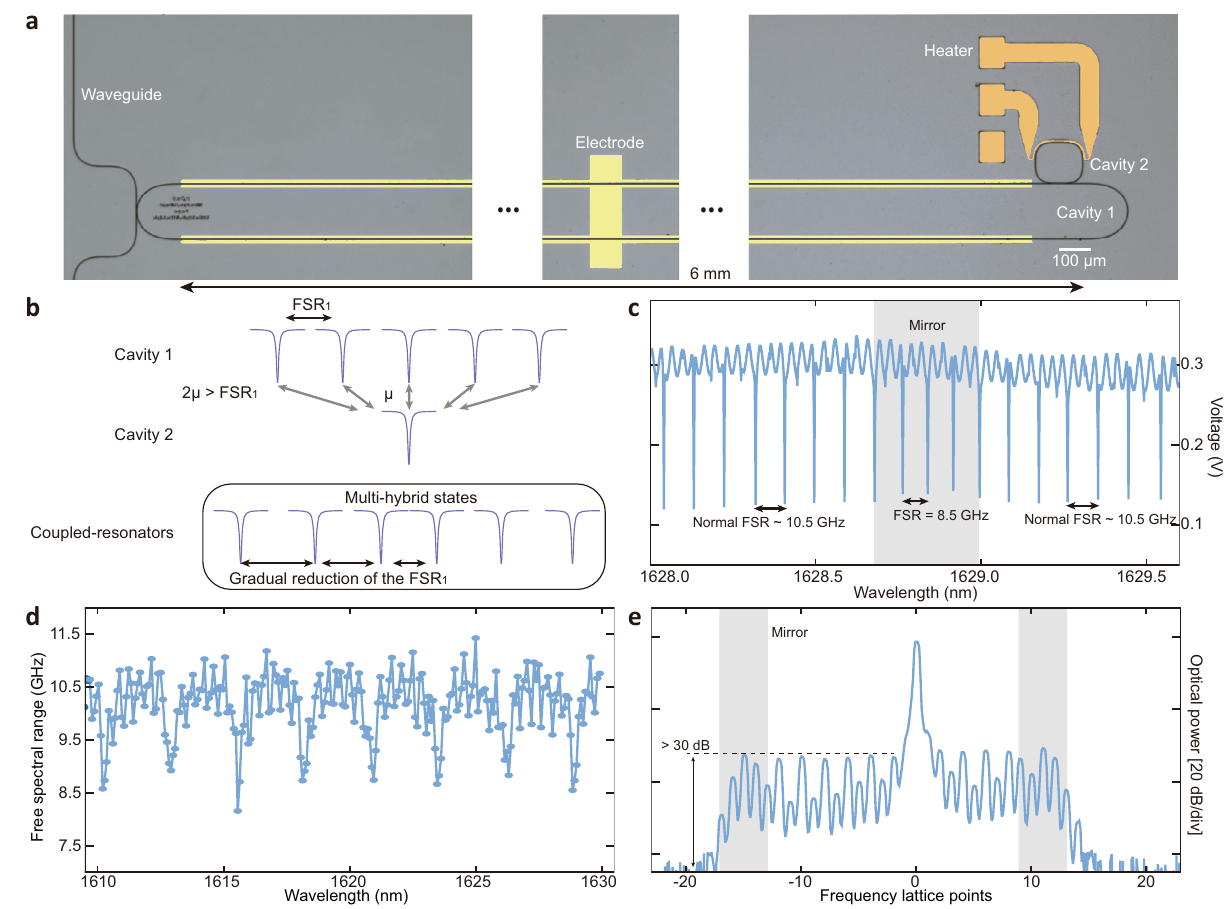
Fig. 4 | Forming trapped states using frequency mirror implemented by coupled-resonators. a Optical image (false-color) of the device. A long racetrack shape cavity (cavity 1) with FSR 1 of 10.46GHz is used to generate the frequency crystal. A rectangular shape (cavity 2) with FSR 2 of 302.9GHz is coupled to the cavity 1 to provide the frequency mirrors. Metal electrodes (light yellow) provides theef fi cientmicrowavemodulation.Thermalheater(orange)cantunetheposition of the mirrors by varying the resonances of cavity 2. b Illustration of the coupling between two resonators when the coupling strength satis fi es 2 μ >FSR 1 or μ is comparable with FSR 1 . In this case, rather than having two-mode splitting of resonances of cavity 1, the single resonance of cavity 2 couples to